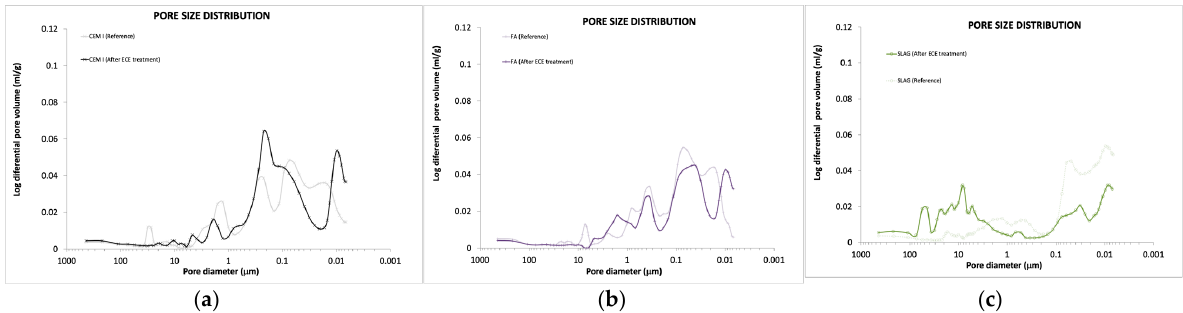
Figure 15. Influence of binder type in the pore size distribution before and after ECE treatment. ( a ) CEM I specimens ( b ) FA specimens; ( c ) SLAG specimens.